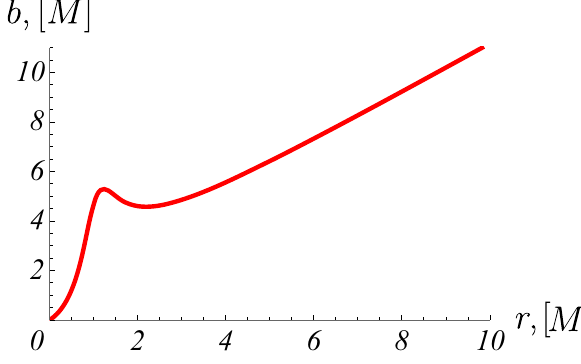
Fig. 5 Dependence of the impact parameter on the photon trajectory’s turning point by φ k and φ k , respectively. They correspond to the max min minimal and maximal values of the celestial coordinate η